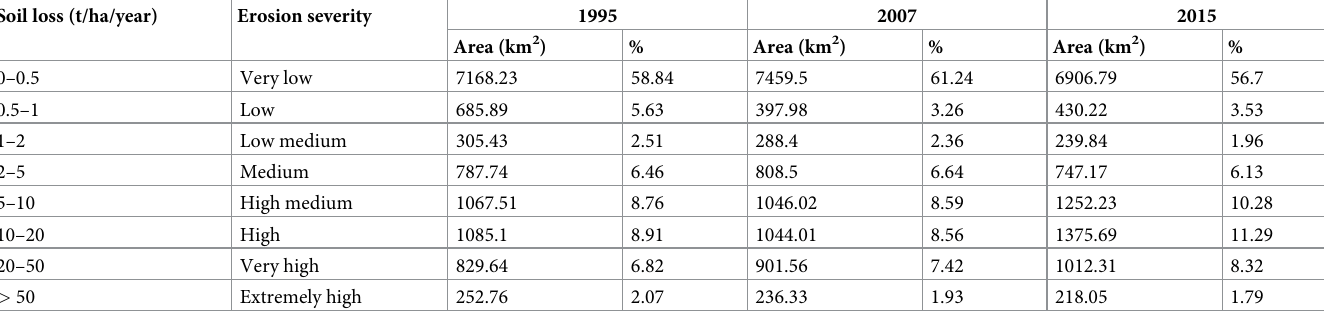
Table 6. Soil erosion classes and severity in the study area through the years 1995, 2007 and 2015.